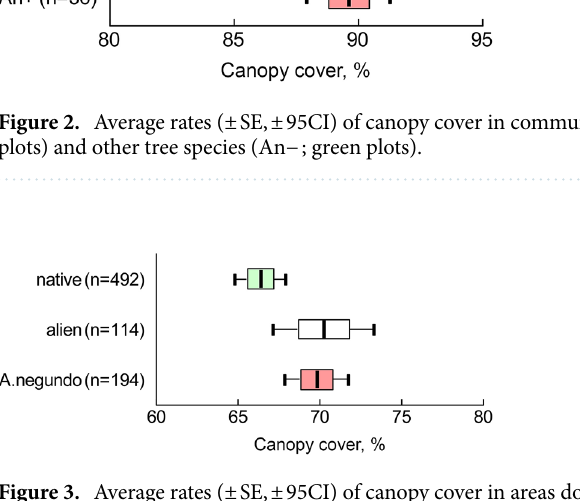
Figure 3. Average rates (± SE, ± 95CI) of canopy cover in areas dominated by native (green plots), alien, excluding Acer negundo (white plots) species and individually— Acer negundo (pink